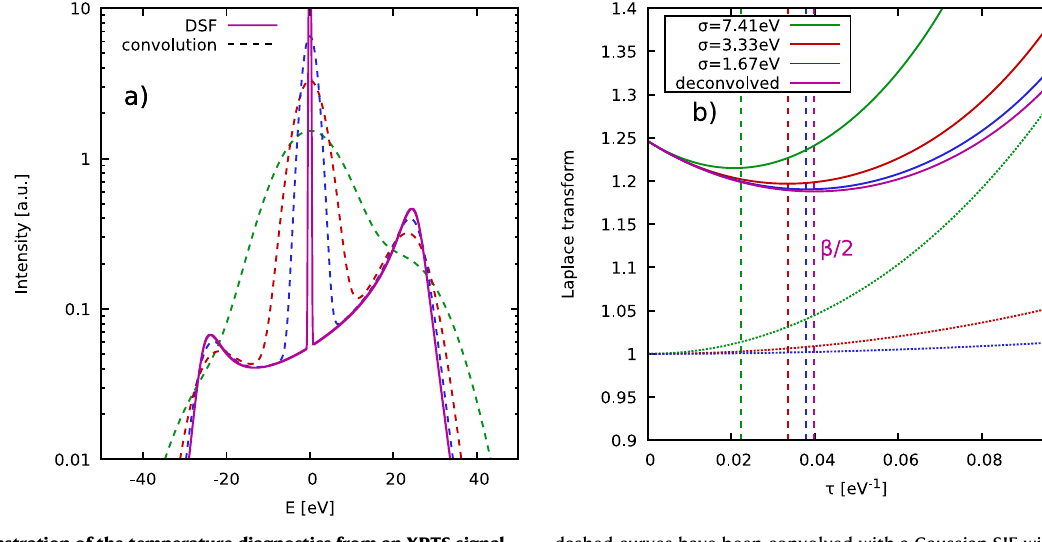
dashed curves have been convolved with a Gaussian SIF with the width σ = 1.67eV (blue), σ = 3.33eV (red), and σ =7.41eV (green). Panel b shows the corresponding evaluation of the two-sided Laplace transform of the respec- tive XRTS signals (solid), and SIFs (dotted). Dividing the former by the latter gives the exact curve of F ( q , τ ) [solid purple] corresponding to the decon- volved dynamic structure factor S ( q , E